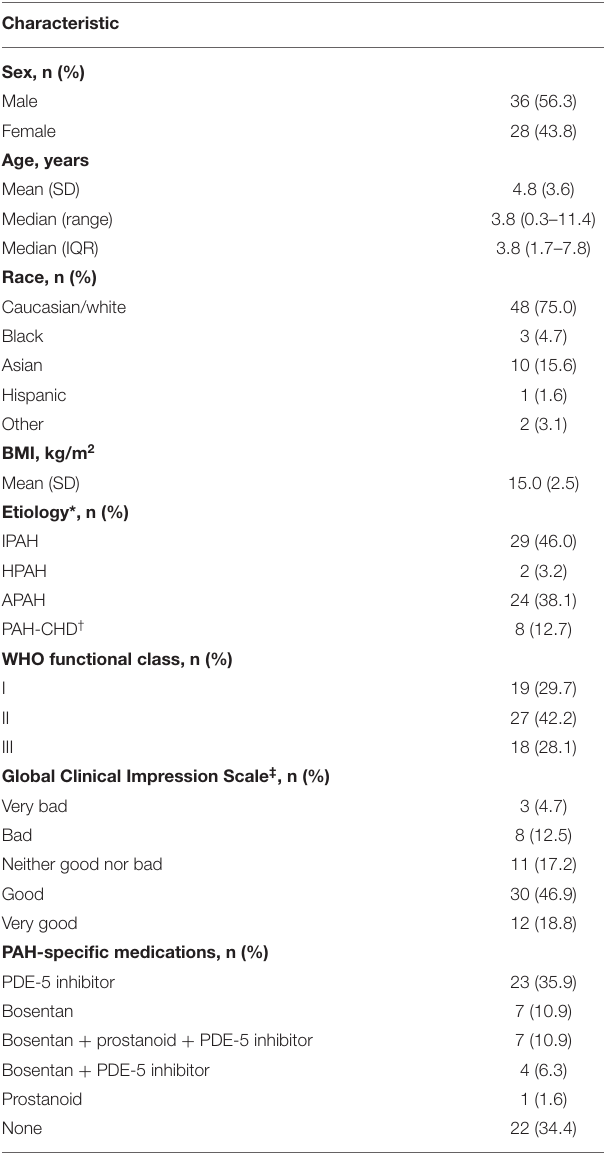
TABLE 1 | Patient characteristics at baseline in the FUTURE 3 trial (all randomized patients; N =